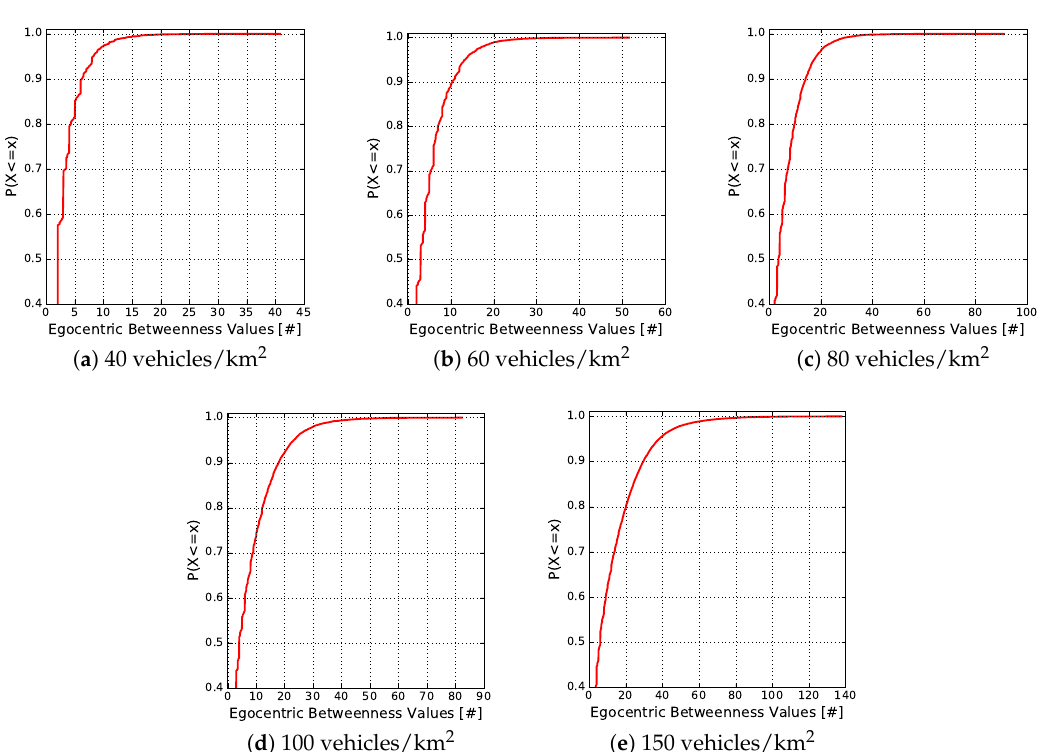
Figure 8. CDF of the egocentric betweenness scores in relation to the vehicle traffic densities.